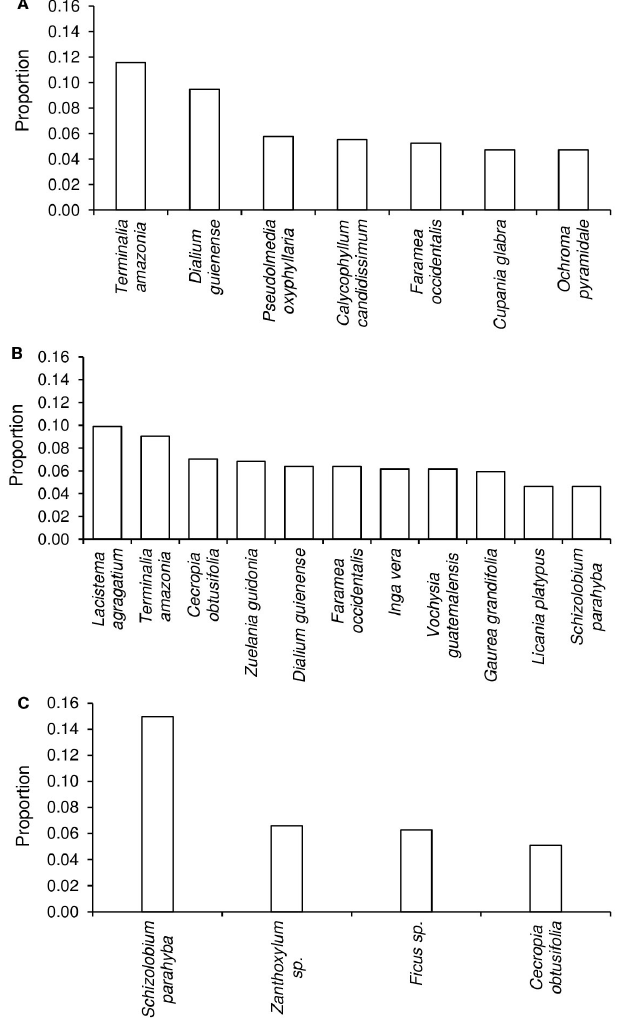
Fig. 4 . Proportional abundance of tree species within a 25-m radius of point counts in (A) evergreen, (B) riparian, and (C) secondary tropical moist forest in Los Chimalapas, Mexico. Only tree species contributing > 5% of tree abundance in each forest type are shown.